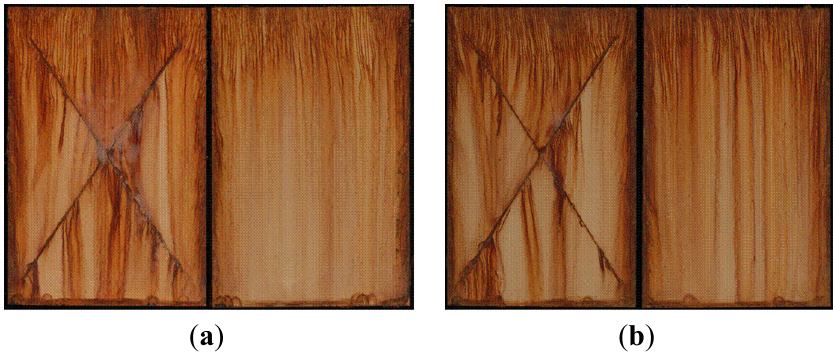
Figure 5. DOD-P-15328D coated on ( a ) as-received and ( b ) grit-blasted 4130 steel coupons with MIL-DTL-53022 primer and MIL-DTL-64159 topcoat after 432 h of NSS